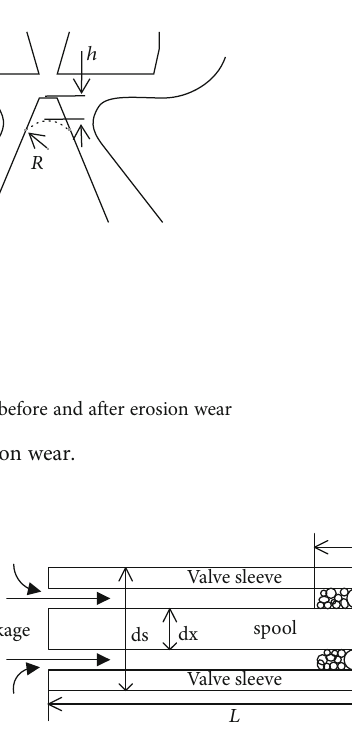
Figure 5: The diagram of fi lter cake formation induced by oil